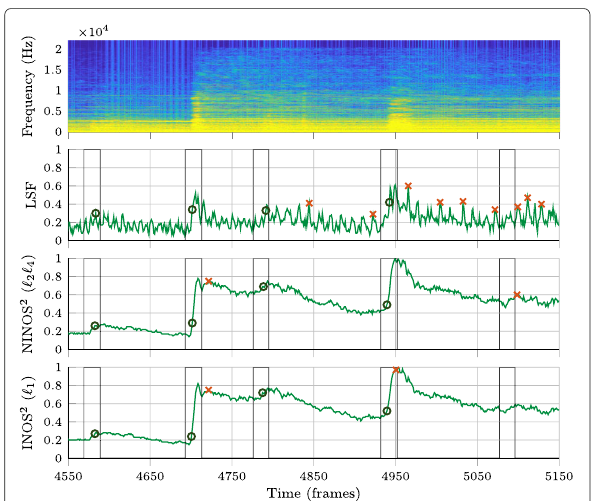
Fig. 7 Comparison of ODFs and peak-picking results for cello (non-vibrato) excerpt. Vertical lines represent onset detection windows indicating ground-truth onsets. Circles are used to mark true positives in the peak-picking results, while false positives are marked with